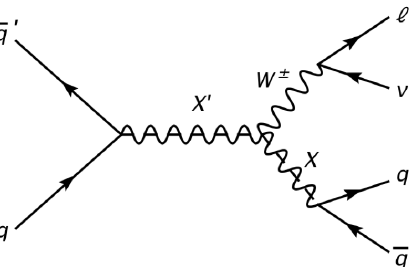
Figure 2. A representative Feynman diagram for a generic resonance, X , decaying to two partons in association with a leptonically decaying W boson in the s -channel. The latter channel includes a resonance X (cid:48) decaying to a W and an X